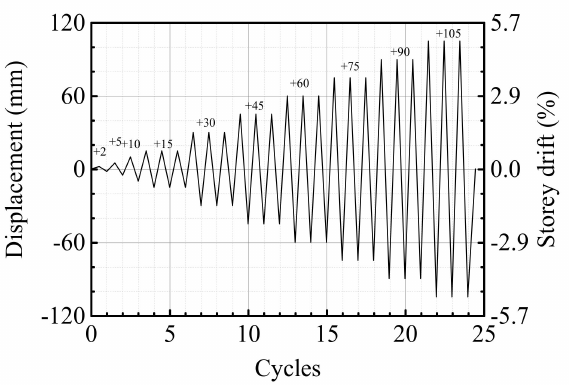
Figure 4. Cyclic loading